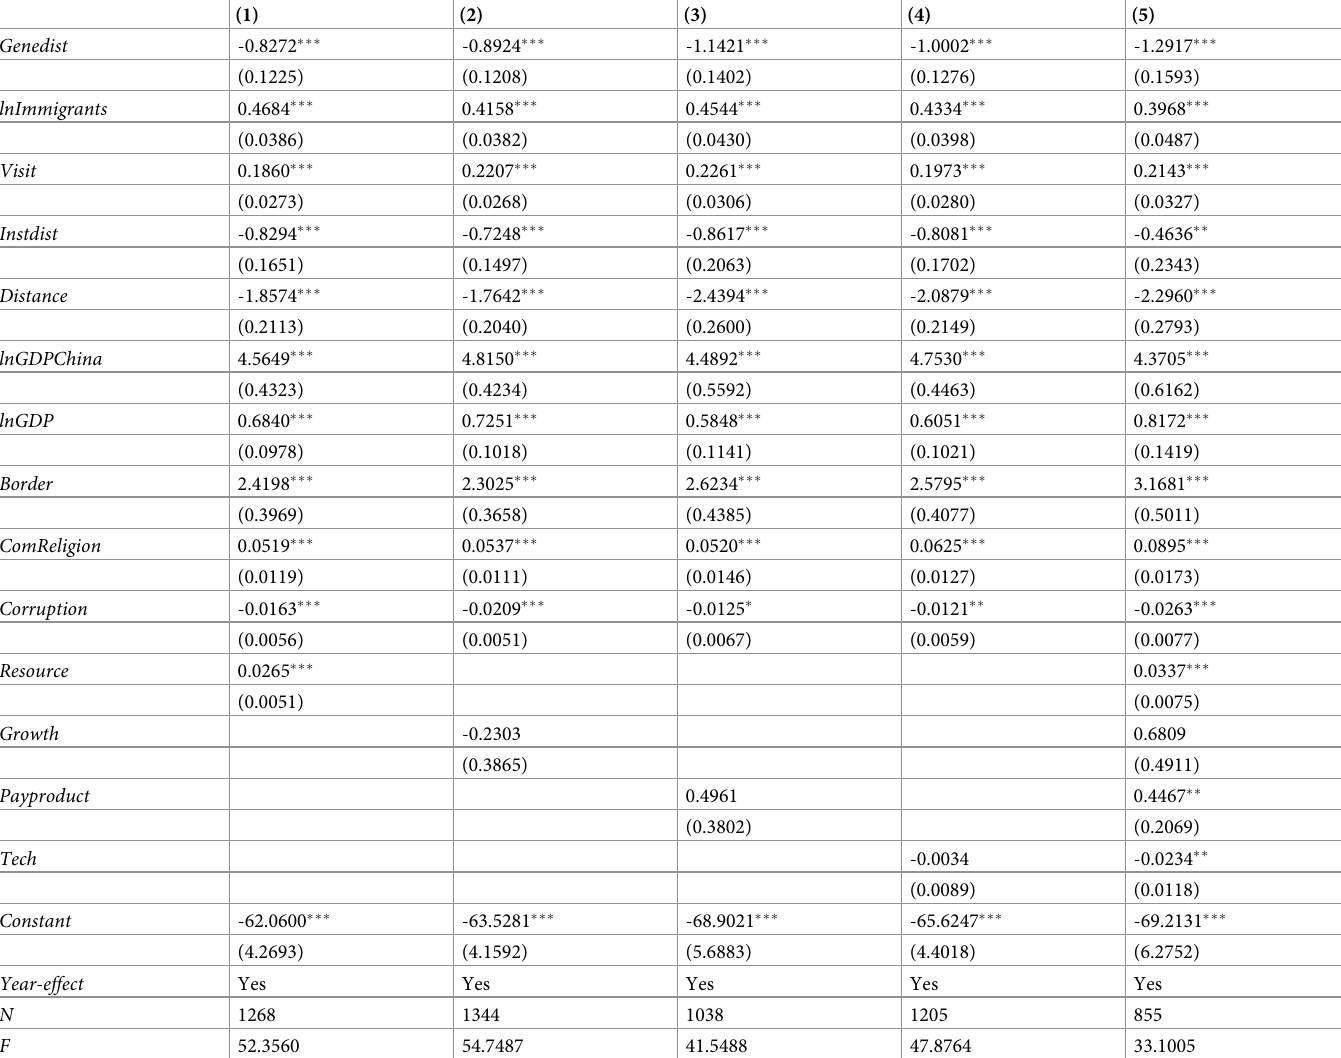
Table 5. The impact of “intimate” relations on China’s OFDI in energy sector: Considering the investment motivations.